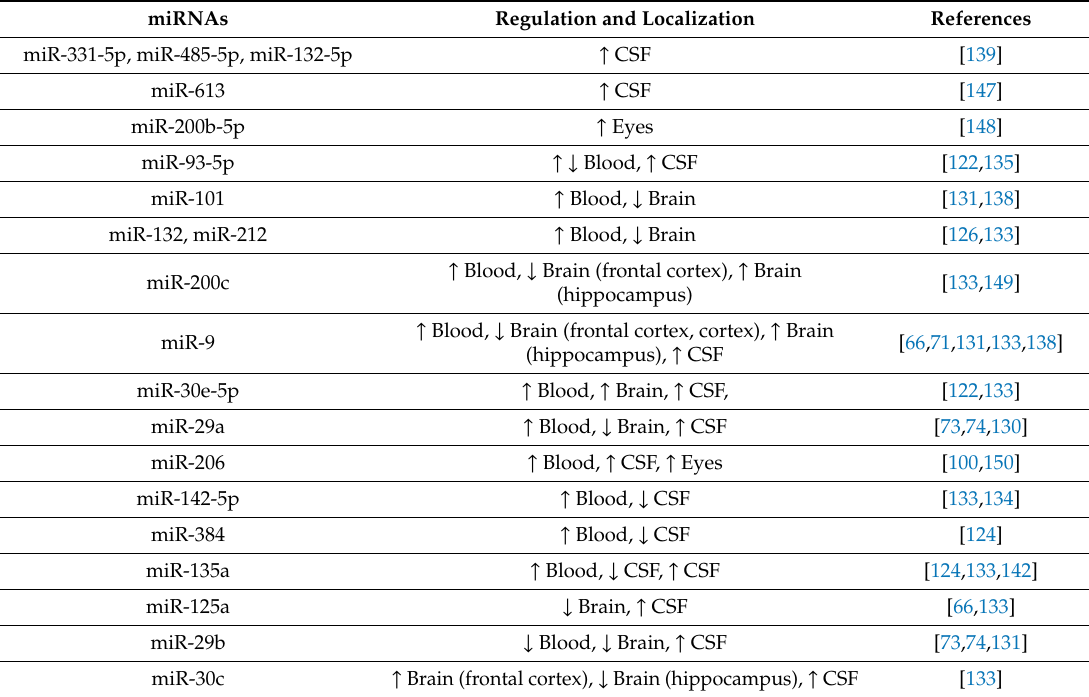
Table 2. Cont. miRNAs Regulation and